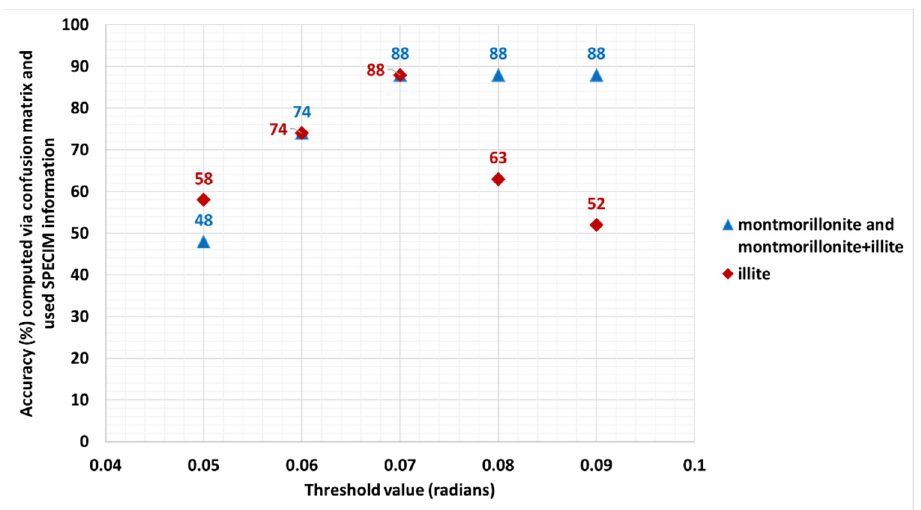
Figure 6. The accuracy of the ASTER mineral map with different SAM derived threshold values for montmorillonite and montmorillonite+illite (blue triangle) when illite threshold value was constant and illite (red diamond) when montmorillonite and montmorillonite+illite threshold was constant.